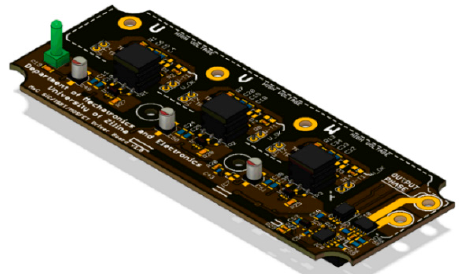
Figure 7. 3D model of the driver board.